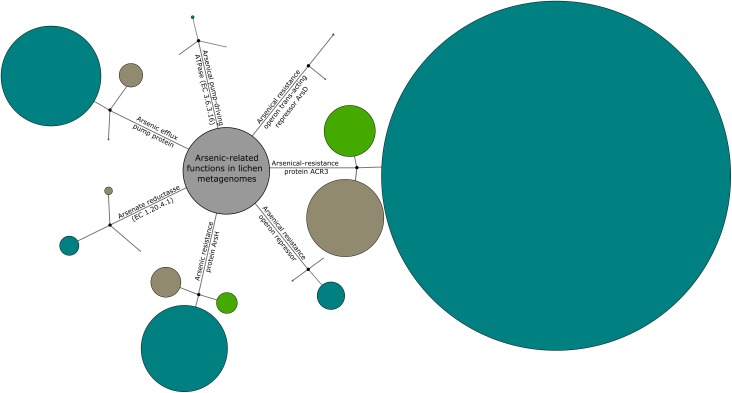
Overview of the prevailing arsenic-related functions in the metagenomes. C. furcata (blue circles) samples were obtained in a locally constrained environment with high As concentrations (Gasen/Austria). P. polydactylon (green circles) was obtained from close vicinity to an urban area (Graz/Austria). The third sample, L. pulmonaria, (brown circles) was collected at a site with the lowest As concentrations (Johnsbach/Austria). The circle sizes correspond to the normalized number of metagenome reads for each function. Additional information on As concentrations at the sampling sites is presented in Supplementary Table S1.